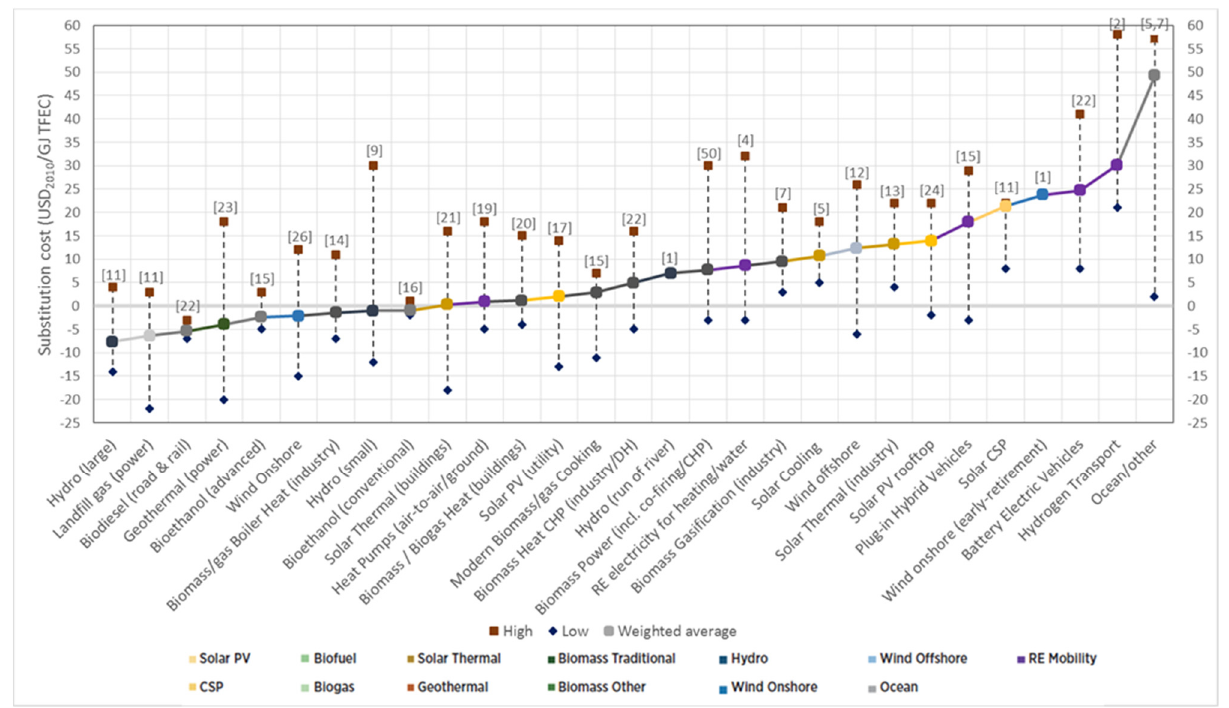
Figure 5. Global average ranges on substitution costs based on the costs differences of REmap countries in 2030. Source: [12]. Dots indicate the weighted average of all countries where different technologies are assumed to be implemented (all indicated with a separate color). The substitution costs of technologies are consistent with the bars shown in Figure